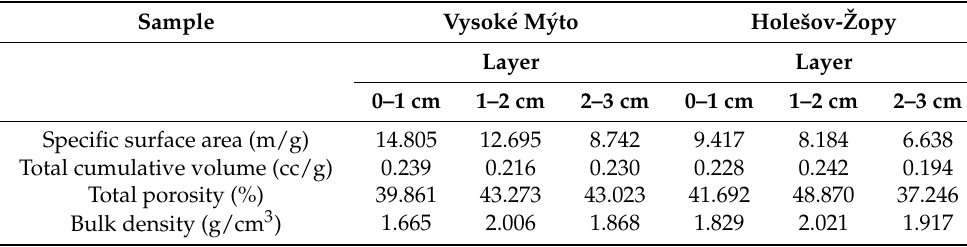
Figure 2. Pore size distribution of individual layer of the brick: Vysoké Mýto (0–1 cm, 1–2 cm, 2–3 cm from the cover). Figure 3. Pore size distribution of individual layer of the brick Holešov - Žopy (0 – 1 cm, 1 – 2 cm, 2 – 3 Figure 3. Pore size distribution of individual layer of the brick Holešov-Žopy (0–1 cm, 1–2 cm, 2–3 cm cm from the cover). from the cover). Table 1. Selected properties of the tested bricks—specific surface area (m/g), total cumulative volume (cc/g), total porosity (%) and bulk density (g/cm 3 ). The mean values from three replicates are used in the table.